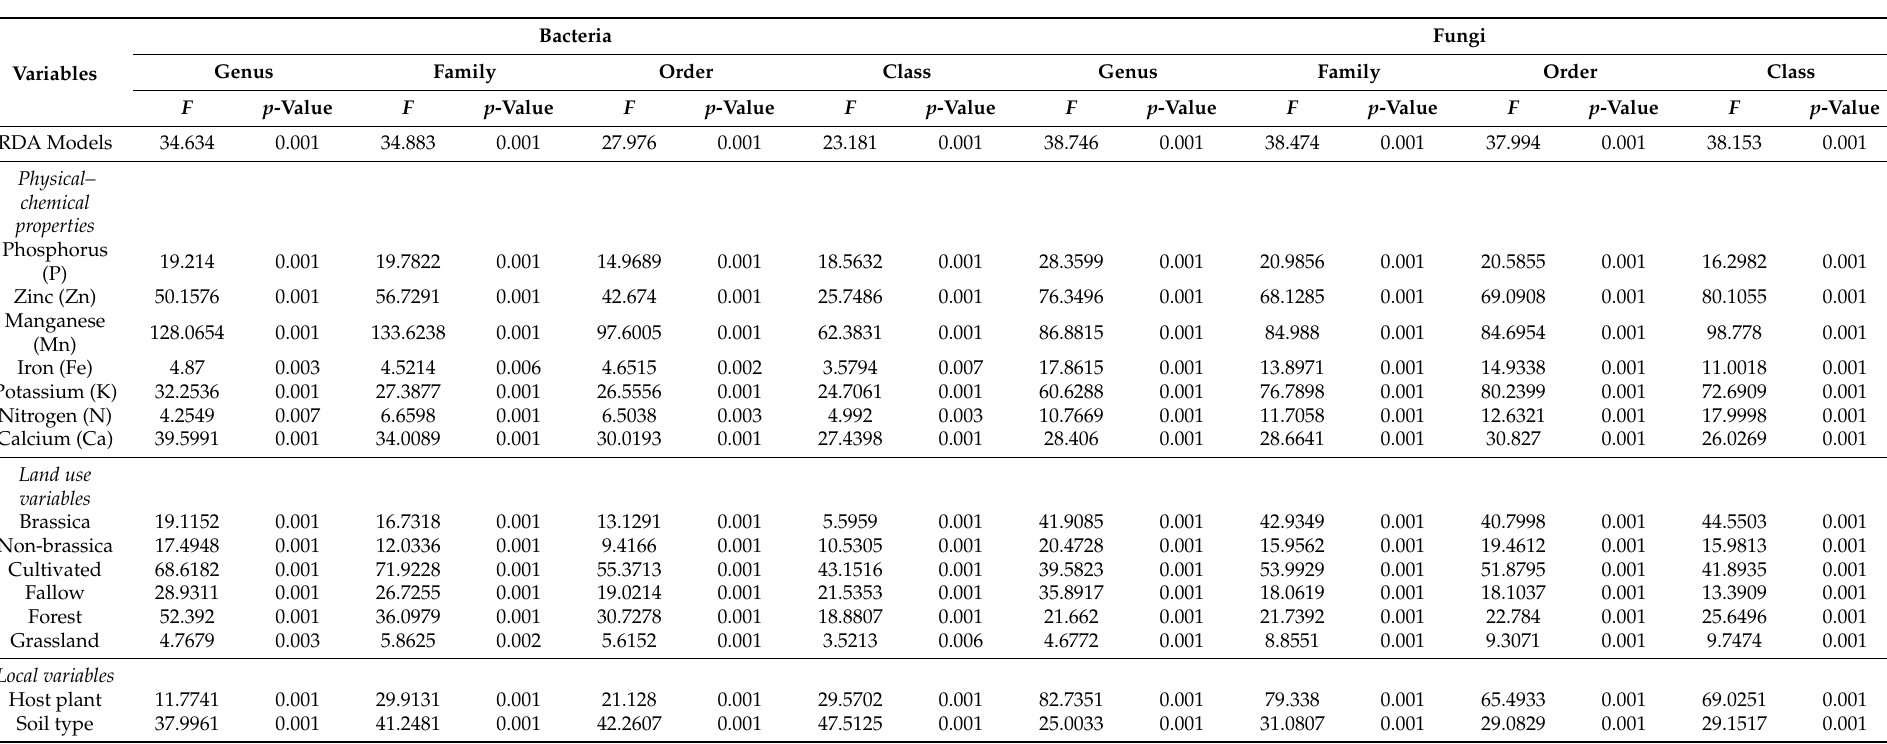
Table 1. The variance in assemblages of bacterial and fungal communities. ANOVA-like permutation test is used for RDA model to assess the significance of constraints. F represents test statistic (pseudo-F), which is the ratio of constrained and unconstrained total inertia (chi-squares or variance), each divided by their respective